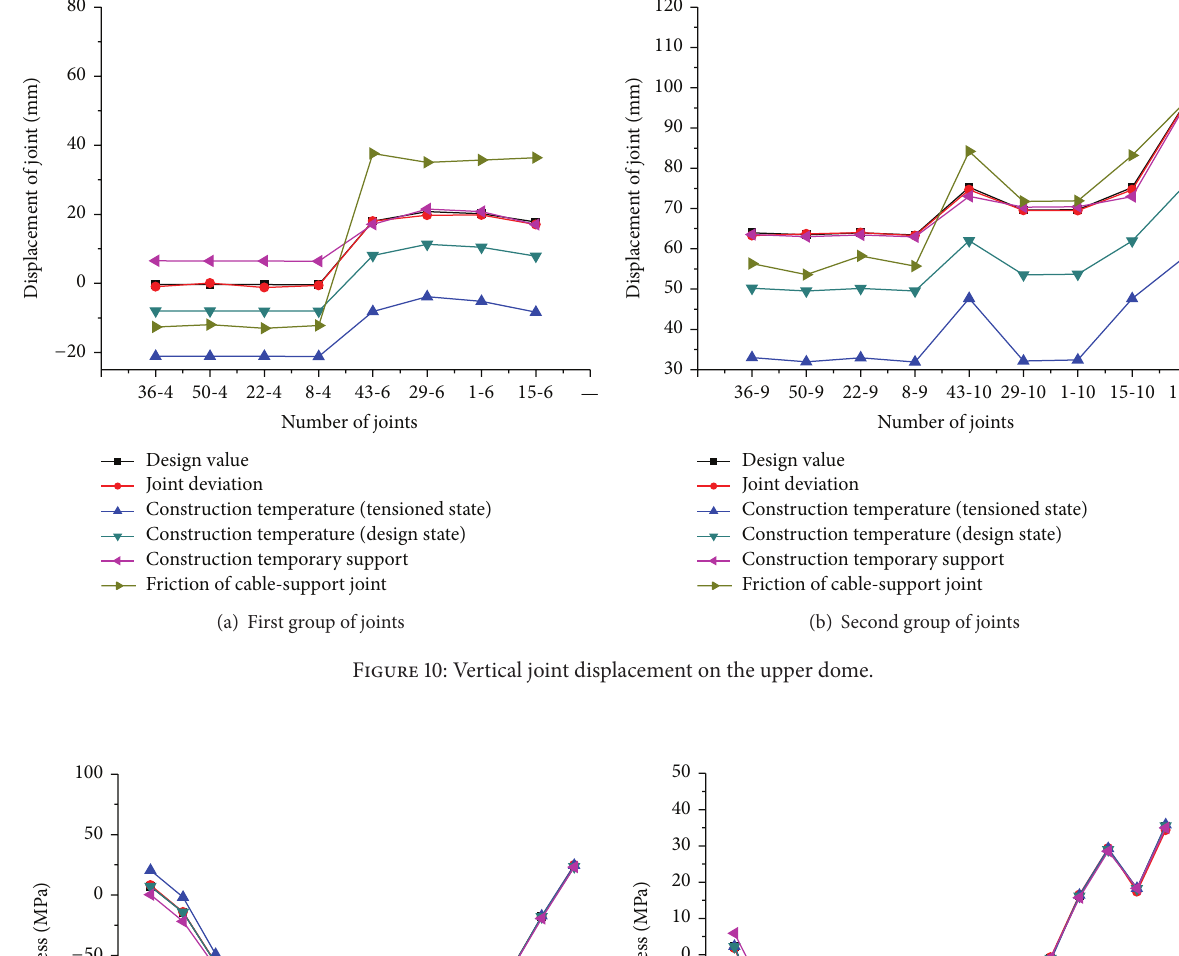
Figure 10: Vertical joint displacement on the upper dome.